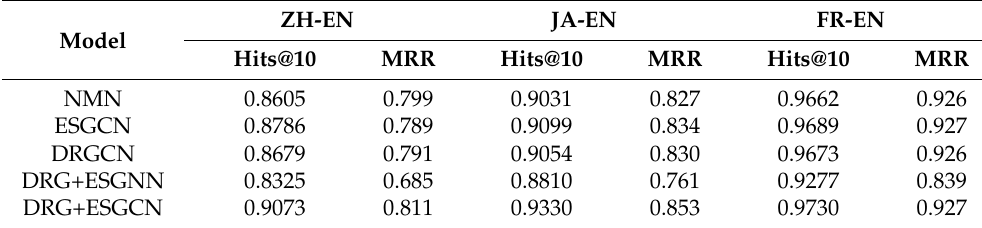
Table 4. The comparison results of the DRG+ESGCN and its variants in the ablation experiments. ZH-EN JA-EN FR-EN Model Hits@10 MRR Hits@10